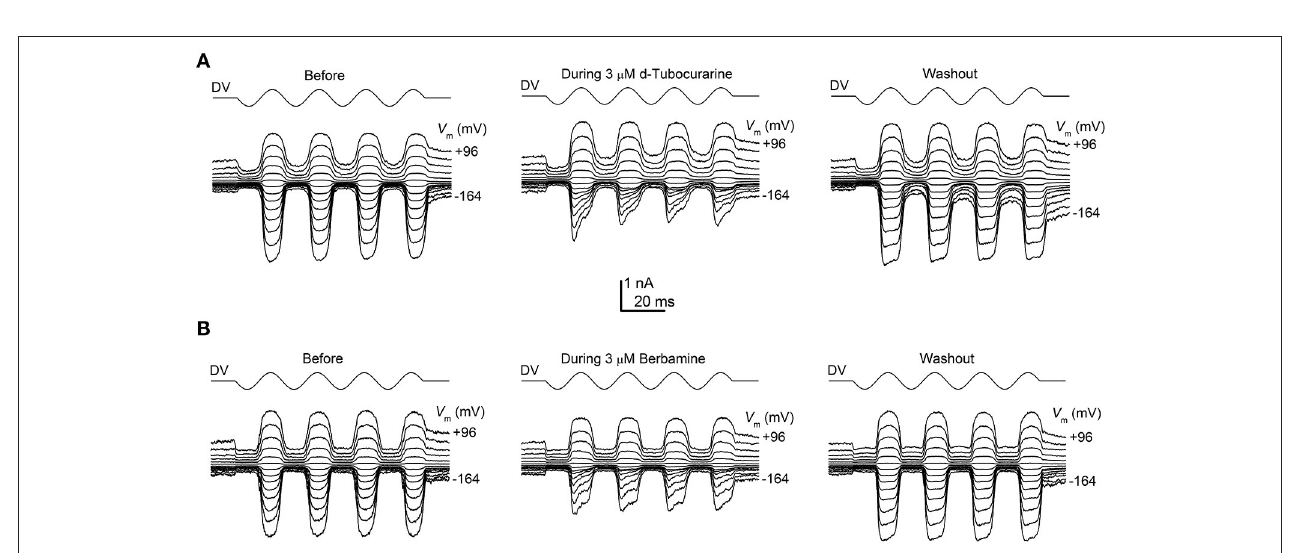
FIGURE 5 | Extracellular d-tubocurarine and berbamine block the OHC MET channel. (A,B) MET currents recorded from P2 + 2 OHCs before, during and after superfusion with a solution containing 3 µ M dTC (A) or 3 µ M berbamine (B) . Both compounds can be seen to predominantly block the MET currents at hyperpolarized potentials with the block fully reversible as seen from the washouts. Membrane potentials were stepped between − 164 mV and + 96 mV and MET currents were recorded in response to a sinewave delivered by a fluid jet (45 Hz sinusoid, ± 40 V driver voltage, DV) shown above each trace. The capacitances of the cells were 6.9 pF (A) and 7.8 pF (B)